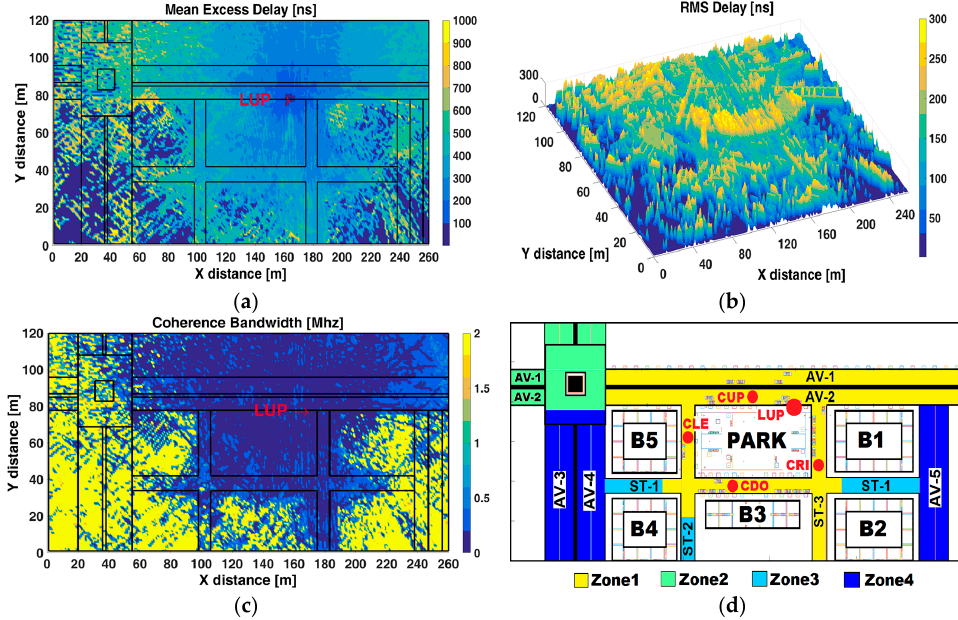
Figure 5. ( a ) Mean Excess Delay; ( b ) RMS delay spread; ( c ) Coherence Bandwith; and ( d ) RSS zone map.